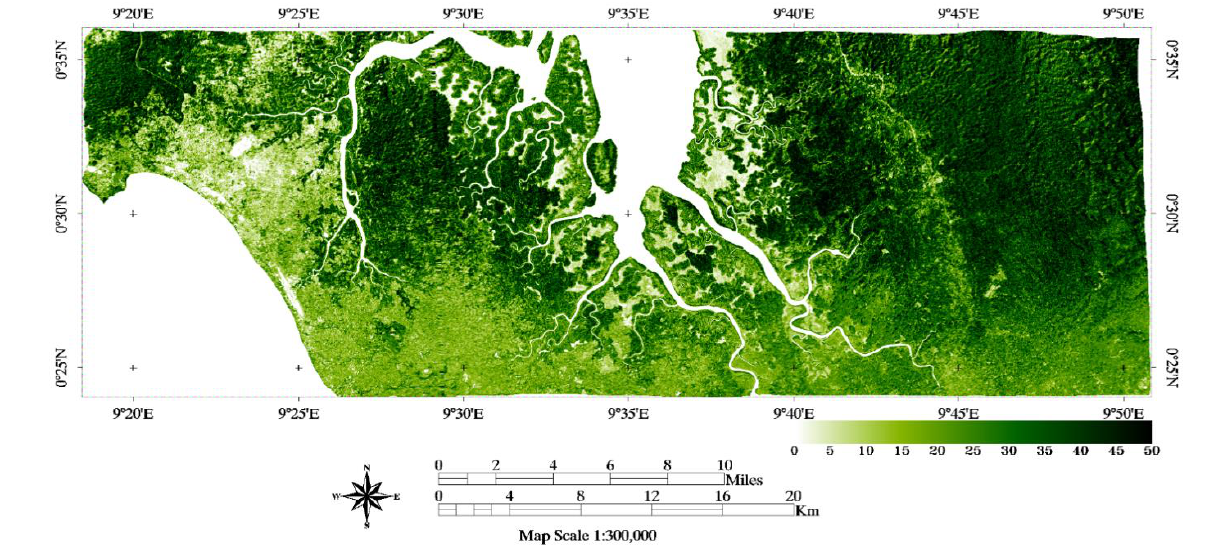
Figure 7. Tree Canopy